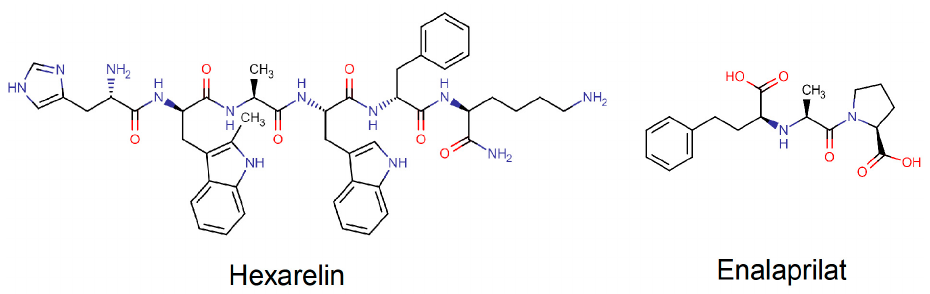
Figure 1. Molecular structures of two peptide drugs: hexarelin and enalaprilat.